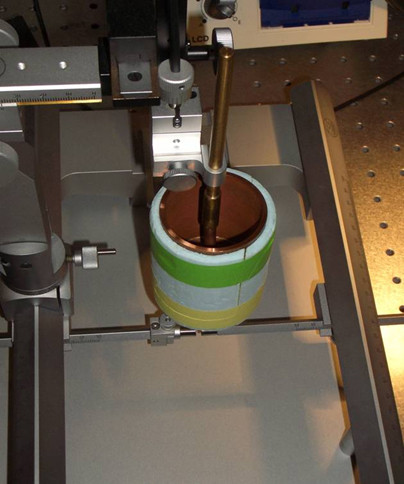
Stereotaxic device.